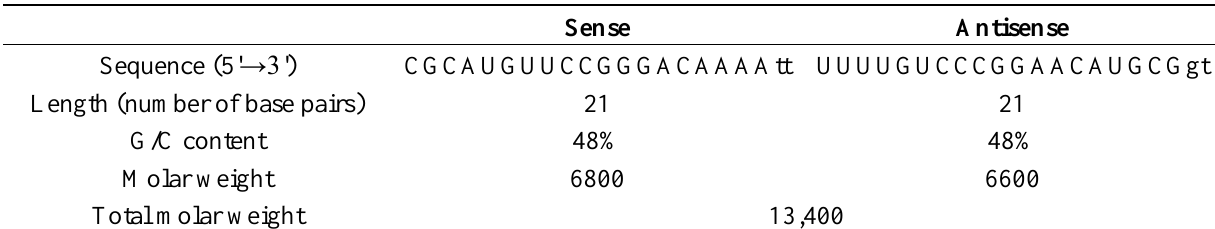
Table 3. Characterisation of